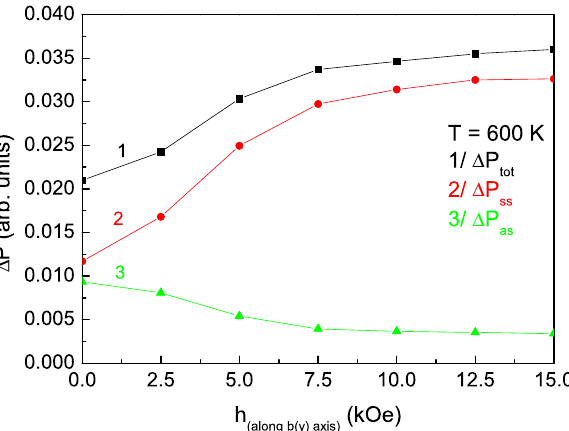
Figure 6. Dependence of the spin-assisted polarization on the magnetic field along the y axis of β -NFO for T = 600 K: (1) ∆ P tot , (2) ∆ P ss , (3) ∆ P as .